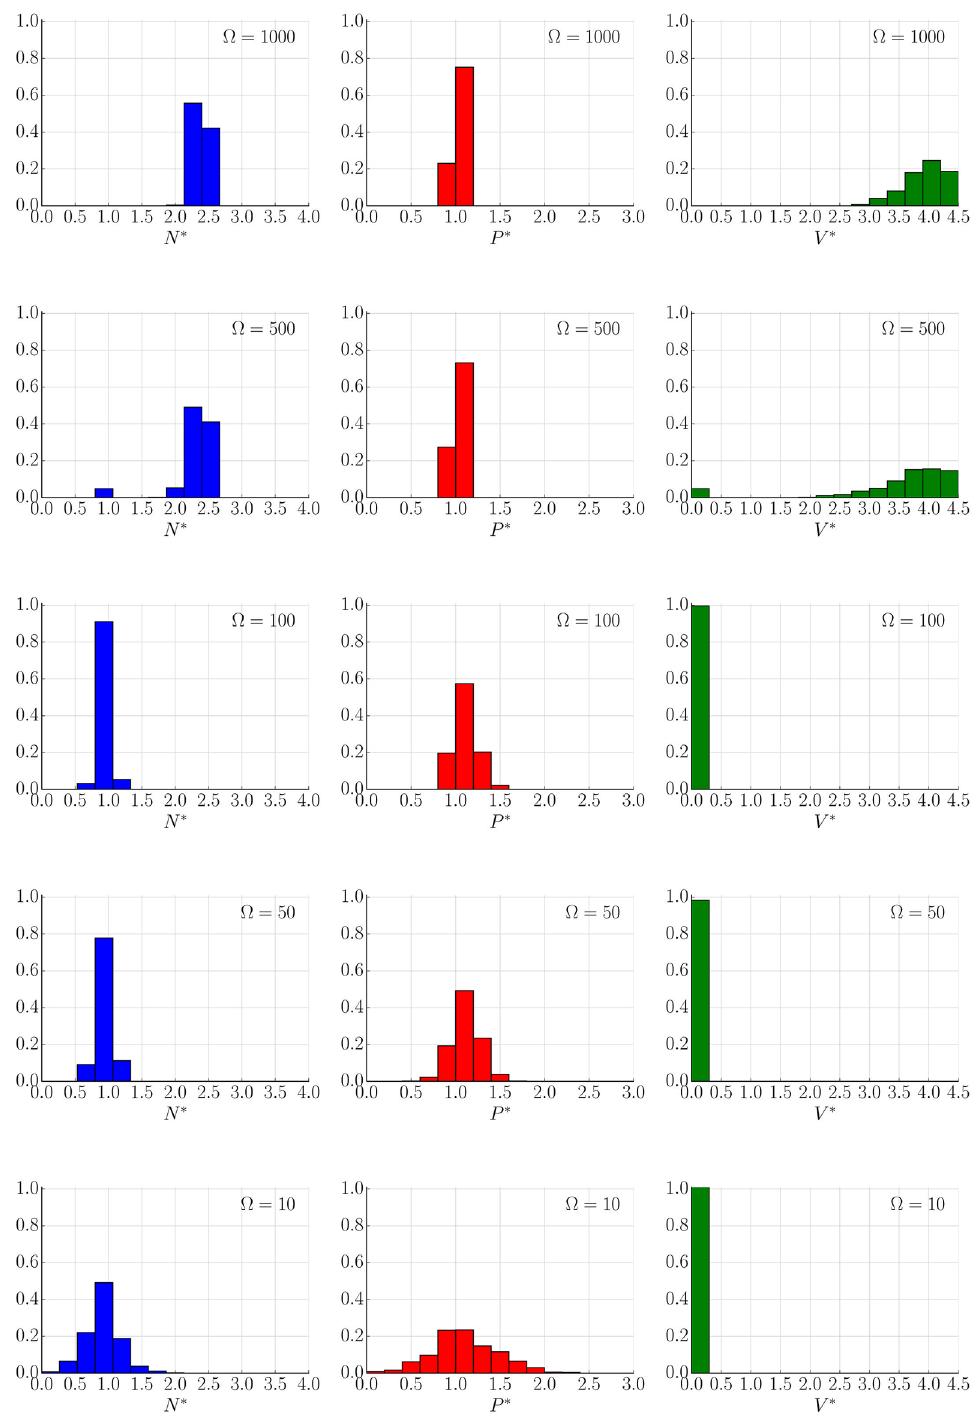
Fig 7. System size determines stochastic populations (Gillespie simulations). Distribution of ( N * , P * , V * ) at time t total = 10000 of 1000 different realizations of Gillespie simulation for different values of Ω = 10, 50, 100, 500 and 1000. Initial condition N * = 2.2, P * = 1.0, V * = 3.5 (close to steady stable state C 3 ). The parameters are those of Fig